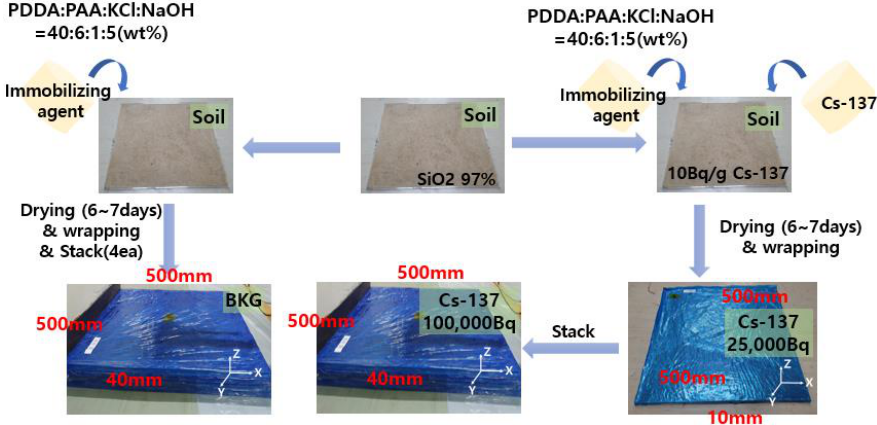
Figure 2. Manufacturing process of contaminated soil with 137 Cs.